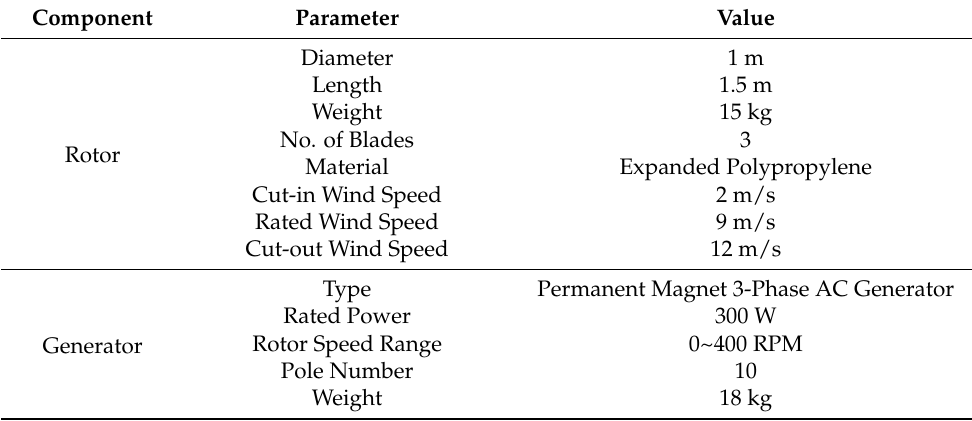
Table 1. Small H-type Darrieus VAWT configuration